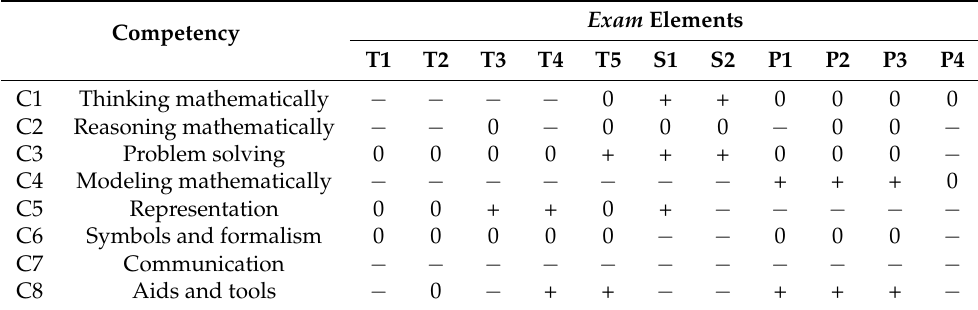
Table 1. Assessments of the level of mathematical competencies in problems from the Exam test 1 .